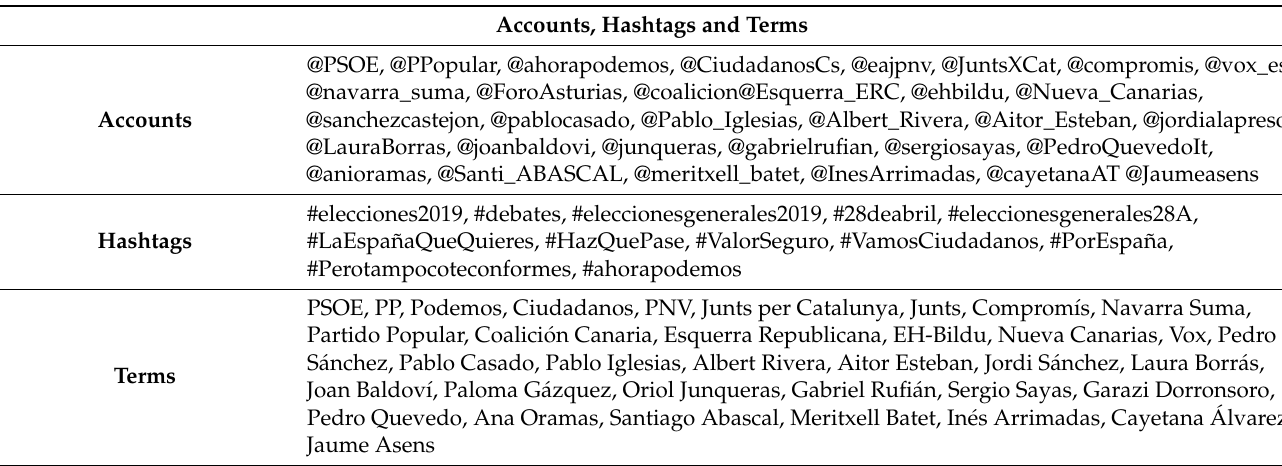
Table 2. Accounts, hashtags, and